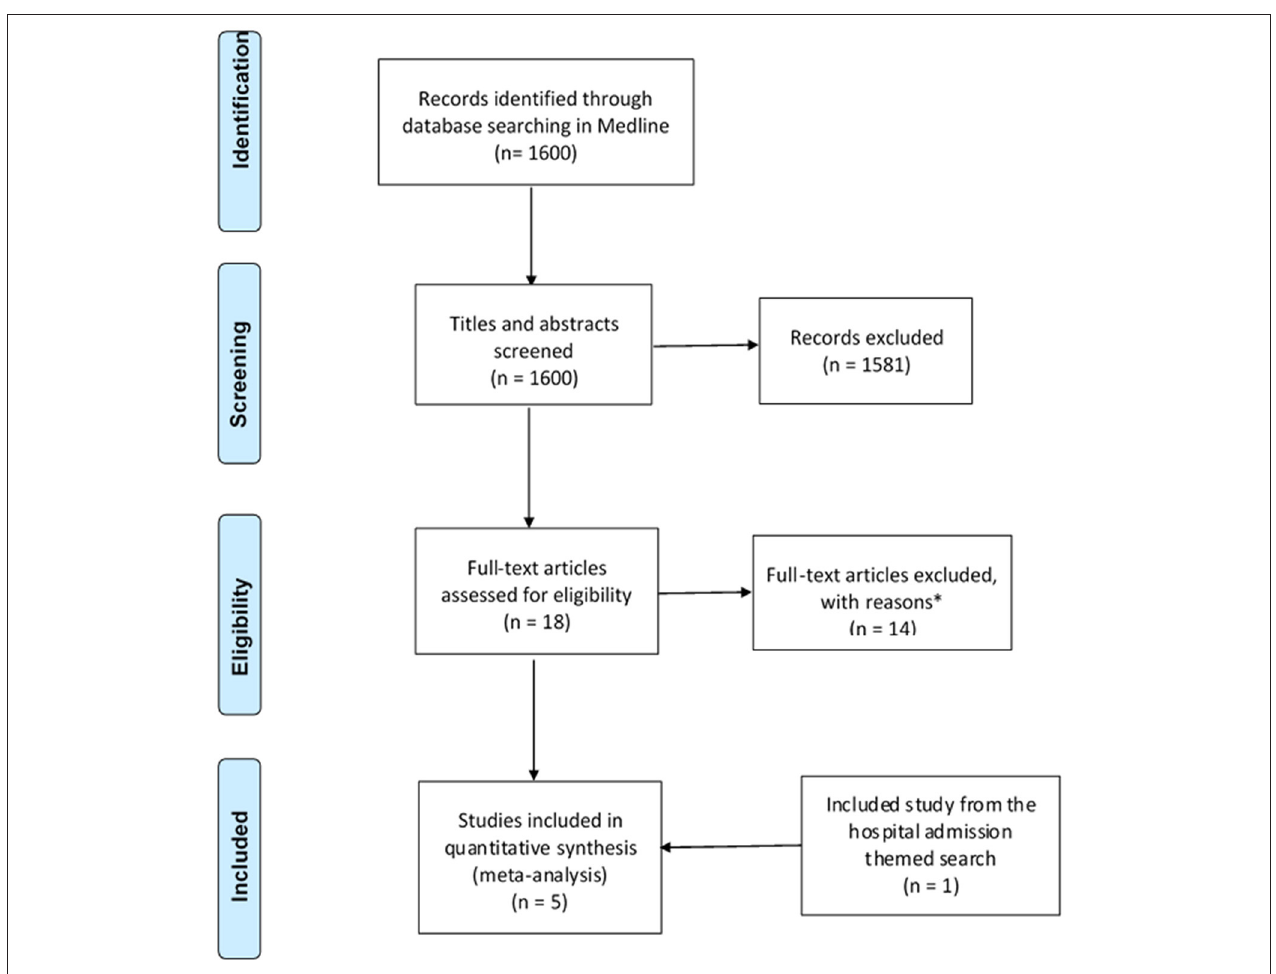
FIGURE 2 | PRISMA flow diagram of literature search and included studies on medication changes themed studies. Adapted from Liberati et al. (2009). *Excluded studies with reasons can be found in Table 2 .